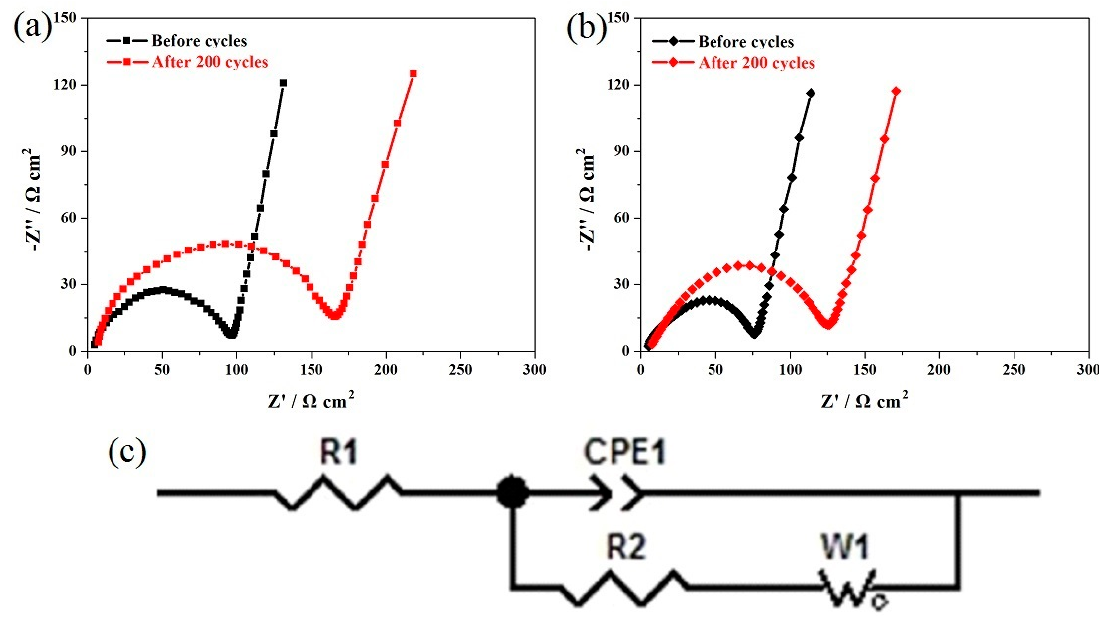
Figure 5. ( a ) Cycling performance and ( b ) rate capacities of the LiCu x Mn 1.95 − x Si 0.05 O 4 (x = 0, 0.05) samples at 55 °C.